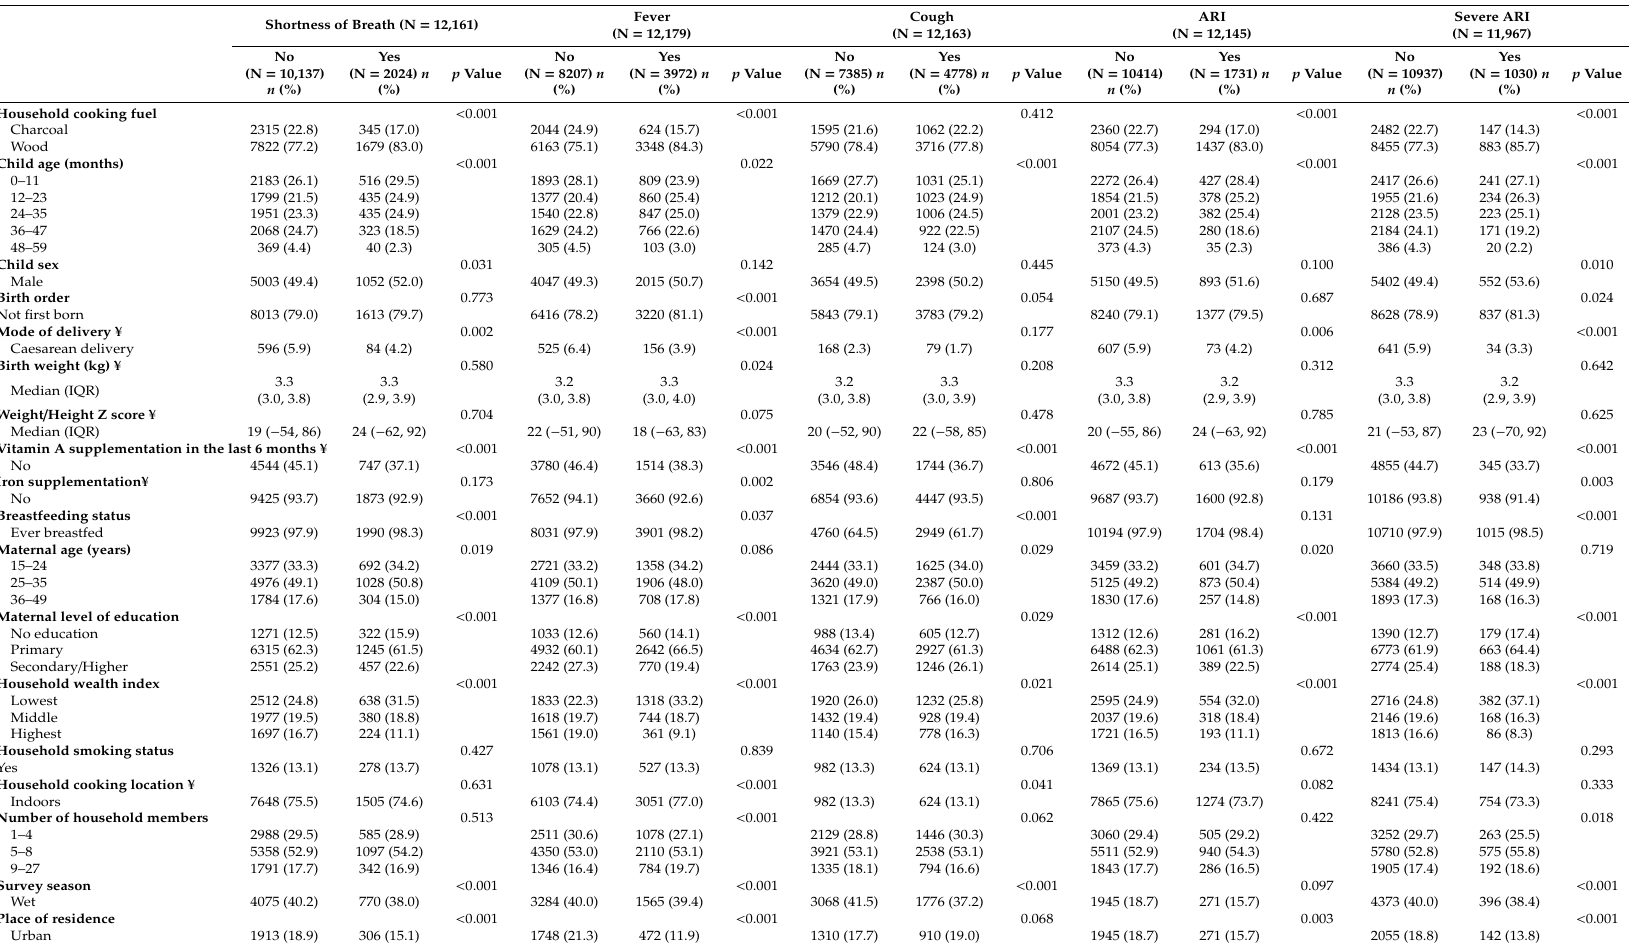
Table 1. Biomass fuel status (all study households) by respiratory outcome measures (frequency,